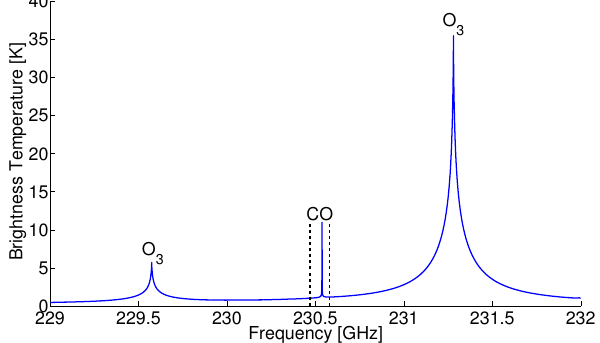
Table 1. Characteristics of the